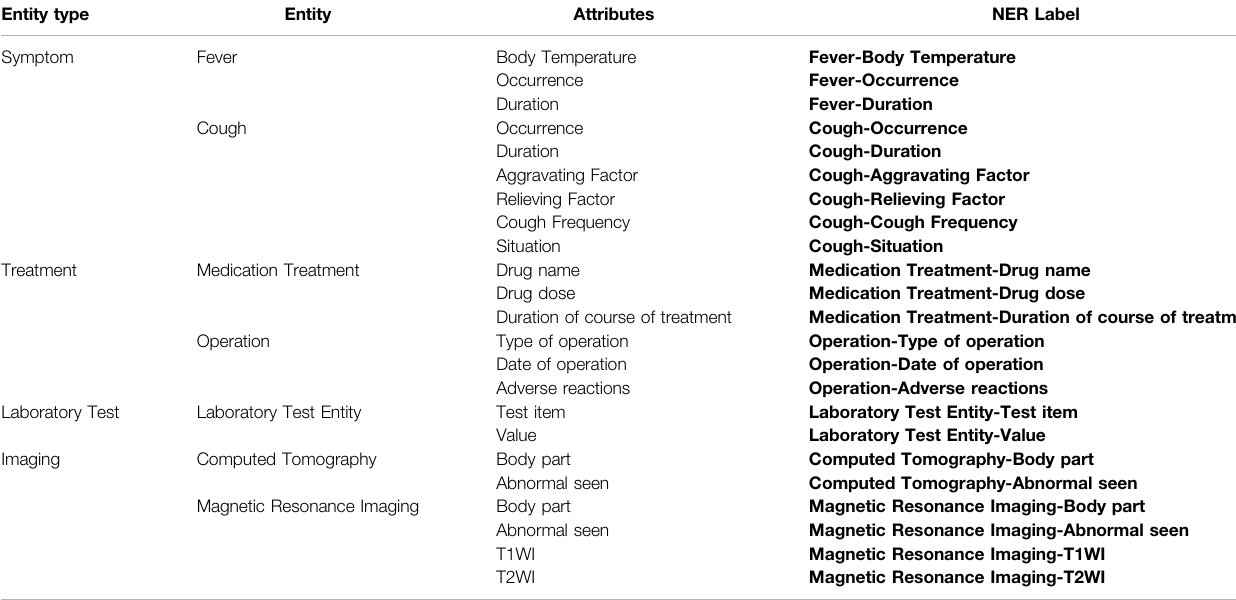
TABLE 3 | Labels for fl at transformation using the schema.